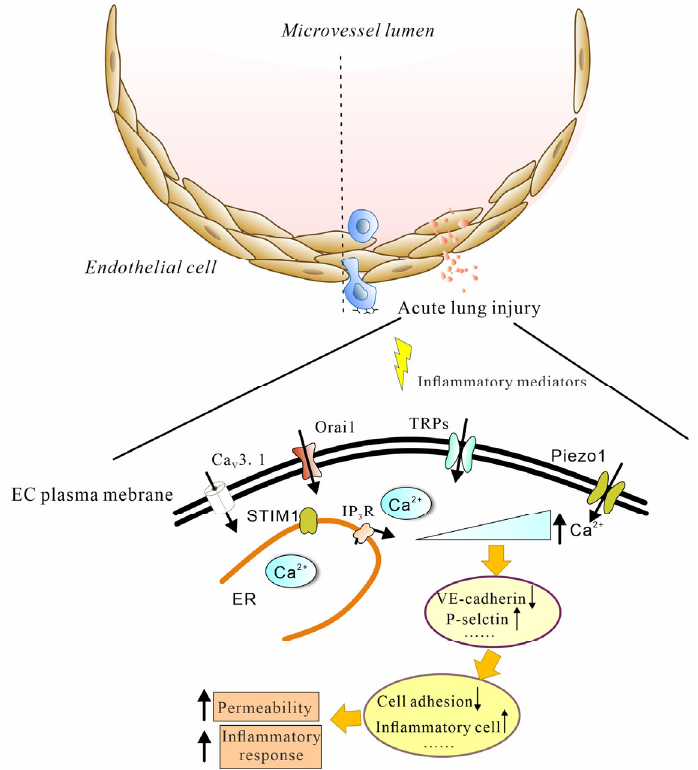
Figure 2. The main calcium channels involved in endothelial cell activation. The activation of ECs is accompanied by the open calcium channel. Ca 2+ influx via these channels leads to increased per- meability and other inflammatory